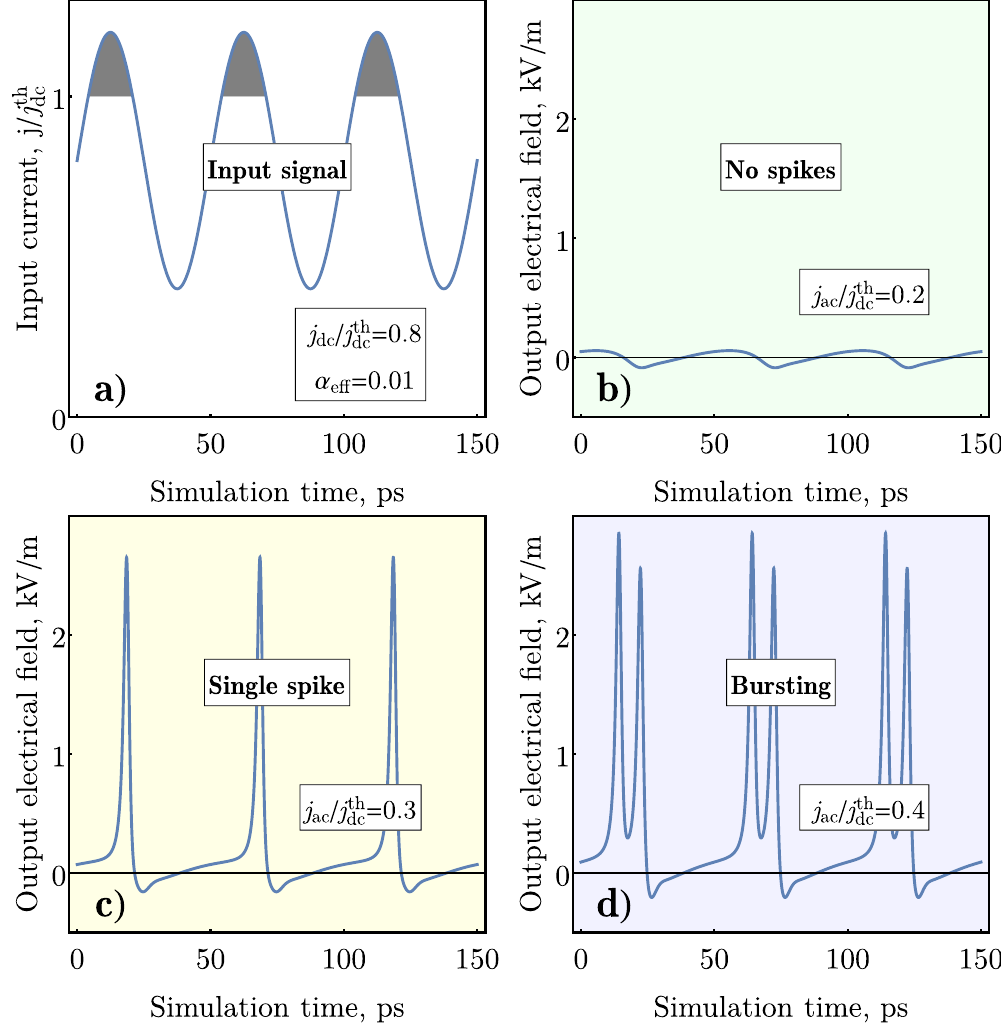
Figure 2. Numerical simulation of different regimes of spike generation in the AFM SHO: ( a ) Shape of the combined (dc + ac) input driving current; ( b ) Regime of no generation (“low” value of the ac current j ac ); ( c ) Generation of a single output spike during each period of the driving ac current (“moderate” values of the ac current j ac ); ( d ) Generation of a discrete group of spikes (bursting) during each period of the AC current (“high” values of the ac current j ac ).